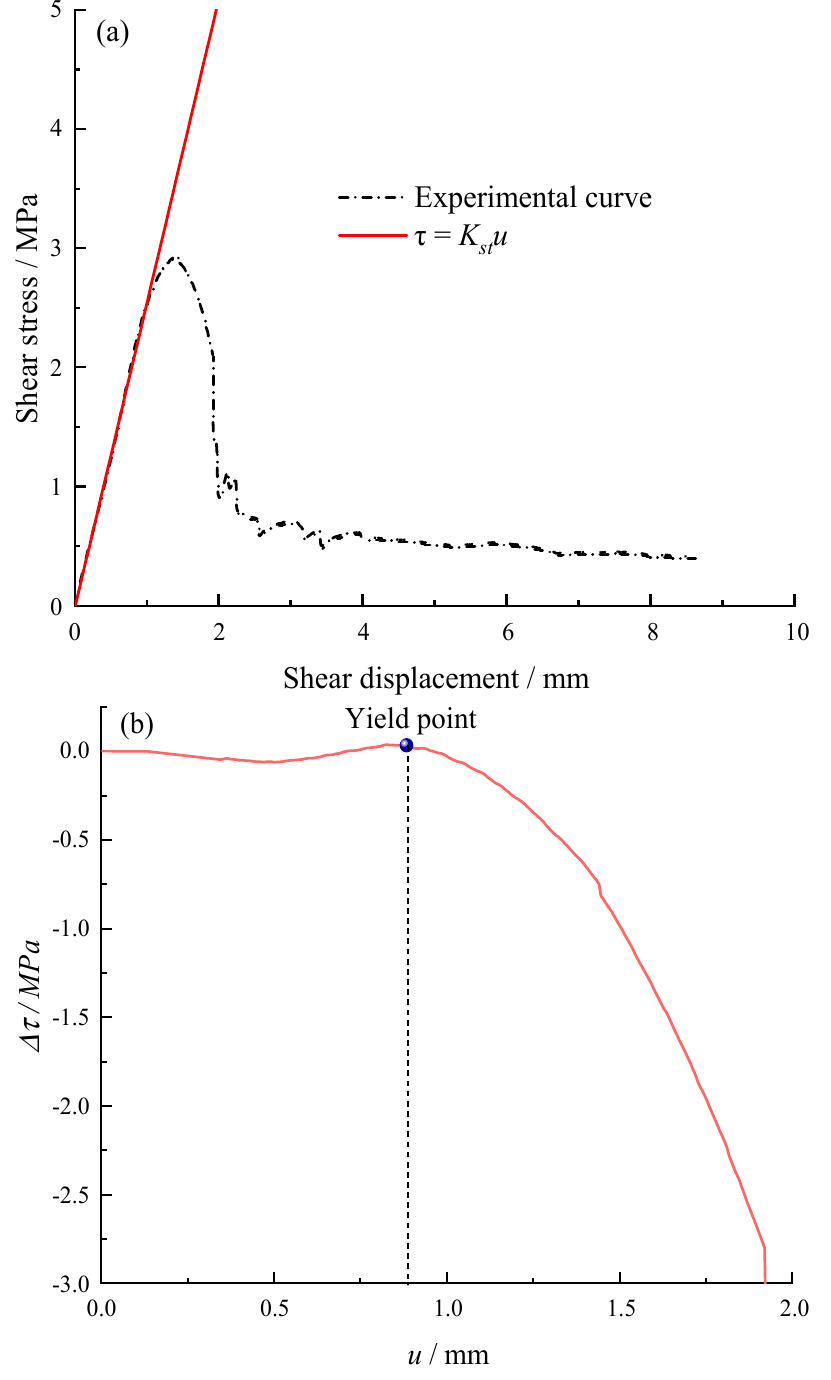
Figure 12. Determination by the inflection point method, ( a ) τ -u curve ( b ) Δτ -u curve. Based on experimental data from previous publications, Table 1 lists the ratio between the yield stress identified by various methods and the peak stress. It can be noticed that with the implementation of the new method, several ratios of yield stress to peak stress are less than 70%, implying that the empirical stress method may occasionally overestimate the yield stress. With regard to the empirical displacement method, in most cases,